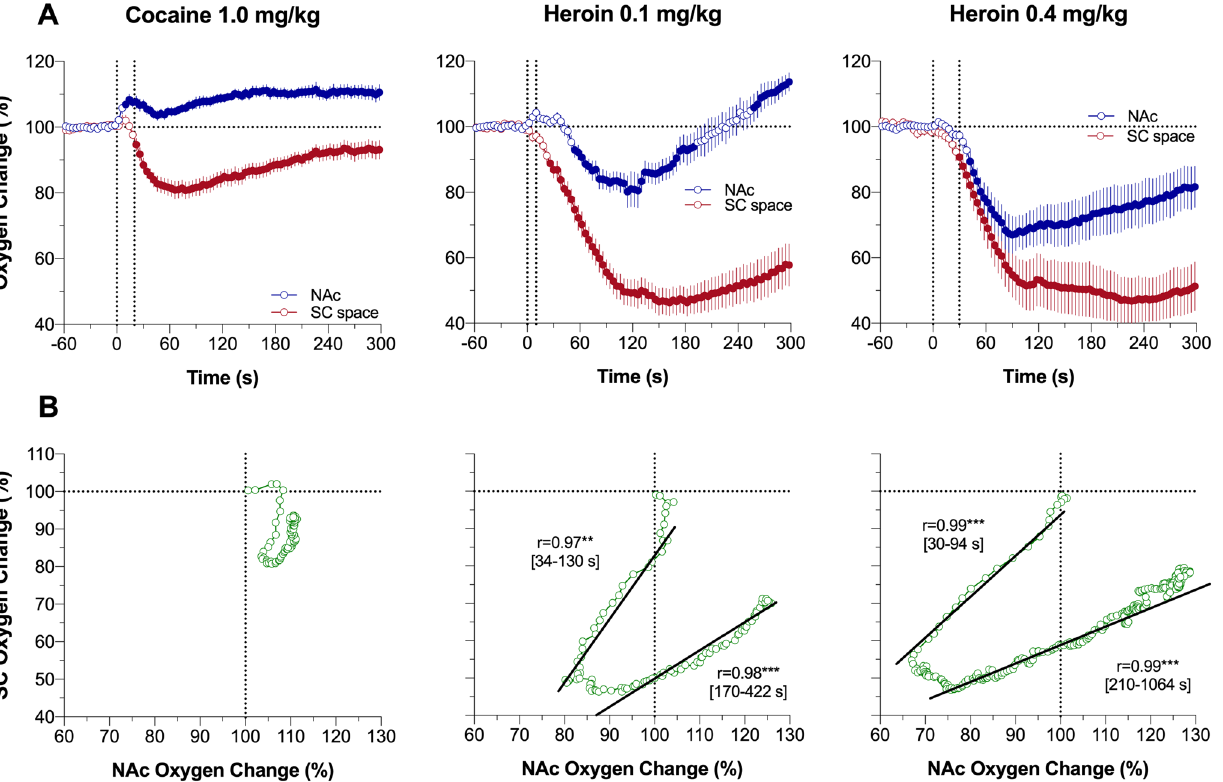
Figure 4. Rapid time-course analysis of relationships between changes in oxygen levels in the nucleus accumbens (NAc) and subcutaneous (SC) space induced by intravenous cocaine and heroin in awake, freely moving rats. ( A ) Mean (± SEM) changes in oxygen levels relative to baseline (100%) calculated with 4-s time bins. Vertical hatched lines show onset and offset of stimulus presentation. Filled symbols mark values significantly different from pre-stimulus baseline ( P < 0.05). ( B ) Correlative relationships between oxygen changes in two recording locations shown separately for oxygen decreases and subsequent oxygen increases (timing of these intervals is shown in brackets). Asterisks show significance of coefficients of correlation (***, P < 0.001 and 0.001,